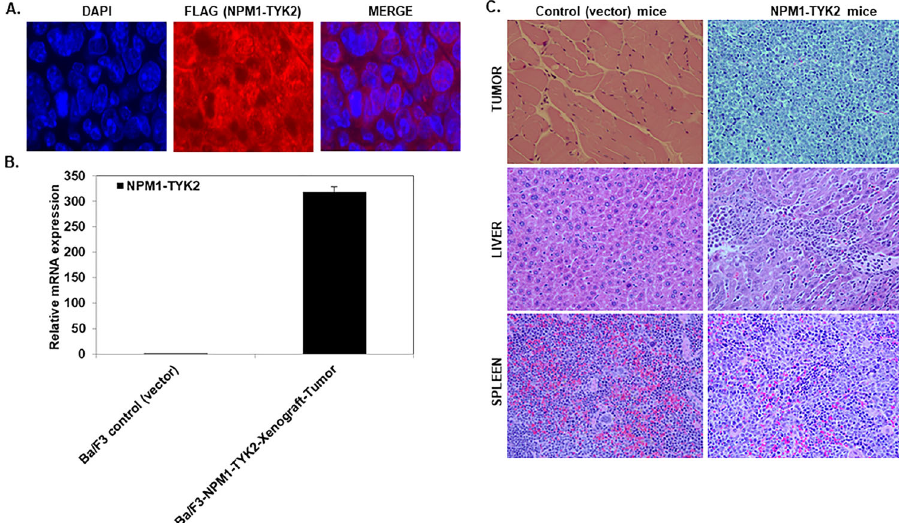
Fig. 5 Detection of NPM1 – TYK2 in tumors and lymphoma cell in fi ltration induced hepatosplenomegaly. A , B Detection of NPM1 – TYK2 (FLAG) in tumors by immunostaining and RT-qPCR. Columns represent the mean of three independent experiments; bars represent the SEM. C Hematoxylin and eosin (H&E) staining of sections from tumor tissue demonstrate lymphoma cell in fi ltration into tumor, spleen, and